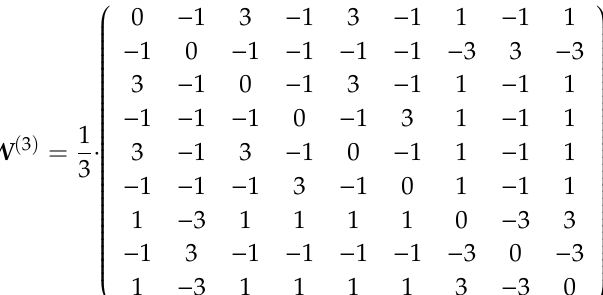
Figure 10. Diagrams of the output voltages of IHN1 neurons for the input template A (Figure 8). Calculation parameters of subfigures ( a , b ) are in Table 3. The arrows in Figure 10a show the trend of U 2 ( t ) and U 3 ( t ) to U max(out) with t → ∞ .